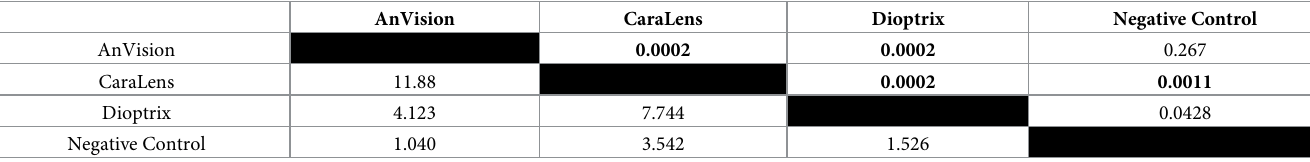
P-values (upper right) and F values (lower left) generated from one—way PERMANOVA of Jaccard similarity indices between microbial DNA detected in each of the brands and negative controls. ( p <